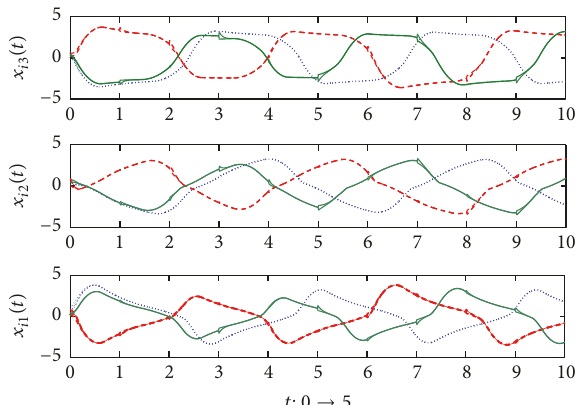
Figure 3: Time evolutions of the Chua oscillators 𝑥 𝑖1 (𝑡) , 𝑥 𝑖2 (𝑡) , 𝑥 𝑖3 (𝑡) (𝑖 = 1, 2, . . . , 8) in the network (33) with the feedback control gains 𝜎 = 𝜎 = 𝜎 = 2 1 2 3